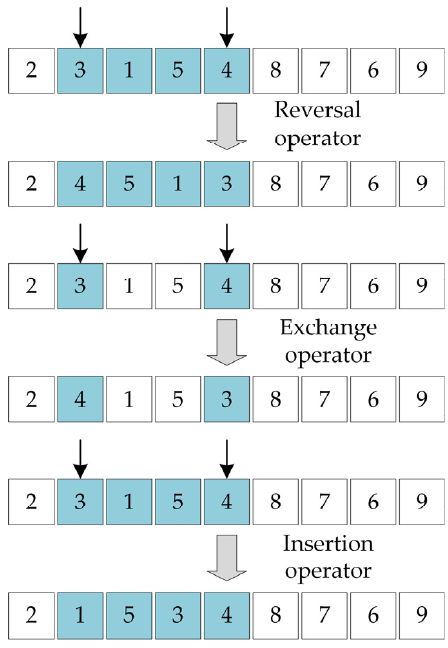
Figure 8. Mutation operator.